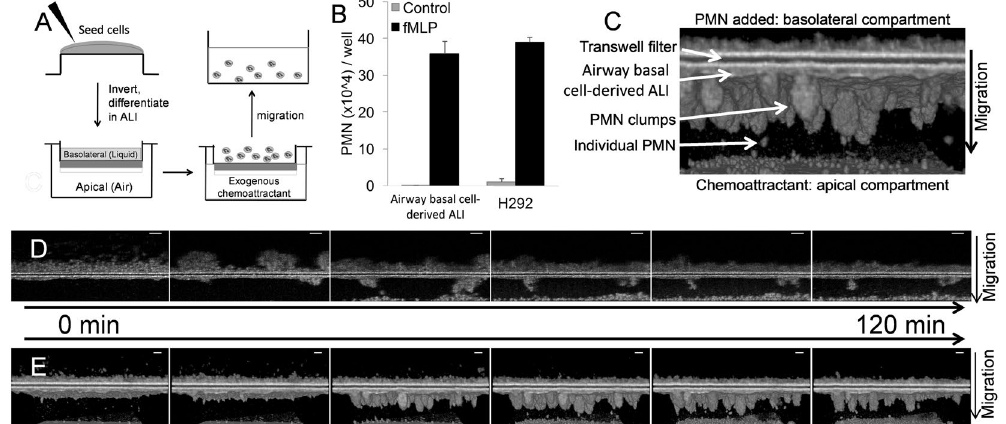
Figure 2. Neutrophil migration in response to an imposed chemoattractant gradient across human airway basal cell-derived ALI cultured epithelial barriers. ( A ) Model schematic of neutrophil transepithelial migration is shown. ( B ) Quantitative MPO read out of fMLP-induced neutrophil migration across epithelium derived from human airway basal cells grown under ALI conditions and H292 cell monolayers, performed in triplicate and replicated ≥ 3 times with similar results. ( C ) µ OCT image of fMLP-induced neutrophil migration is labeled to identify key features within the image. ( D ) Progressive time-lapse µ OCT images are shown of neutrophil migration across human airway basal cell-derived epithelial barriers in response to fMLP gradients over a two hour time course in both 2- and ( E ) 3-dimensions. (PMN = neutrophil). Each depicted migration image was examined by µ OCT and is representative of 3 separate